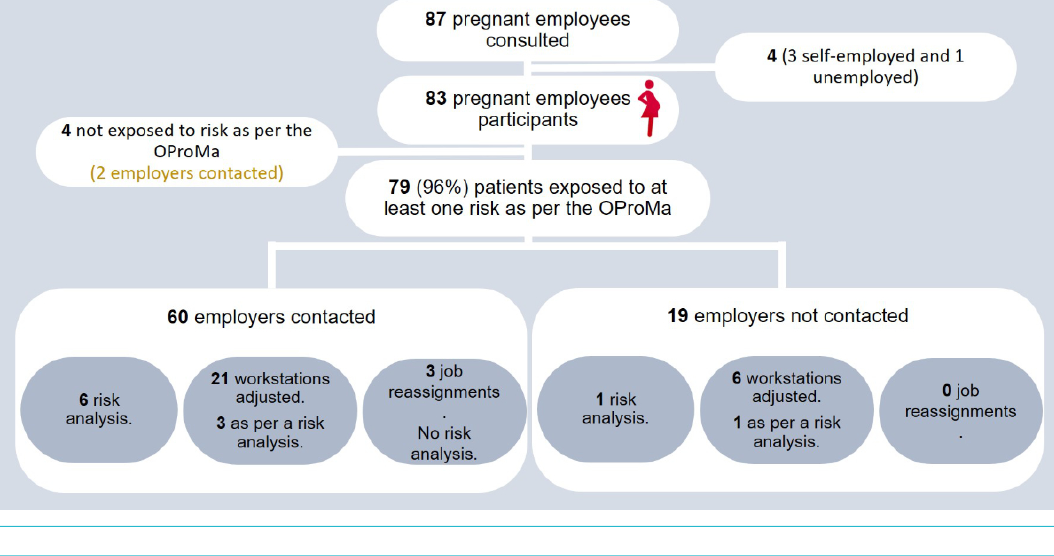
Figure 5: Gynaecologists’ interventions before addressing their patient to the occupational medicine